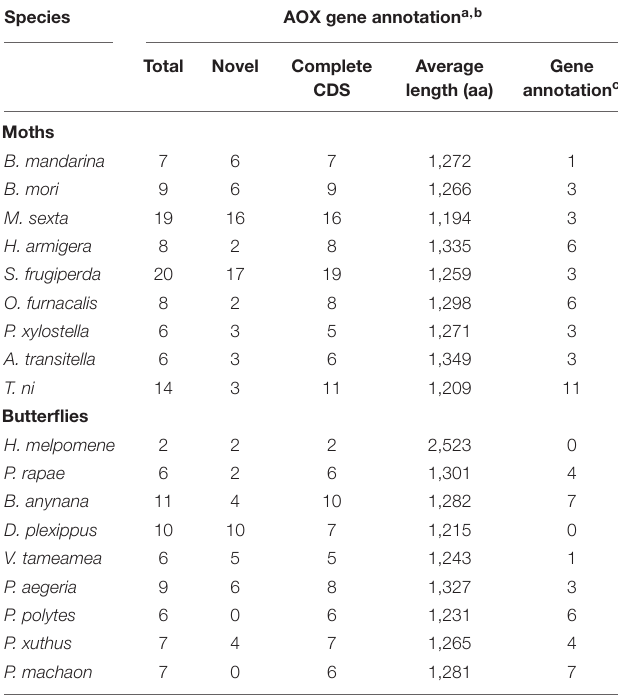
TABLE 1 | Summary of identified aldehyde oxidase genes in moths and butterflies.